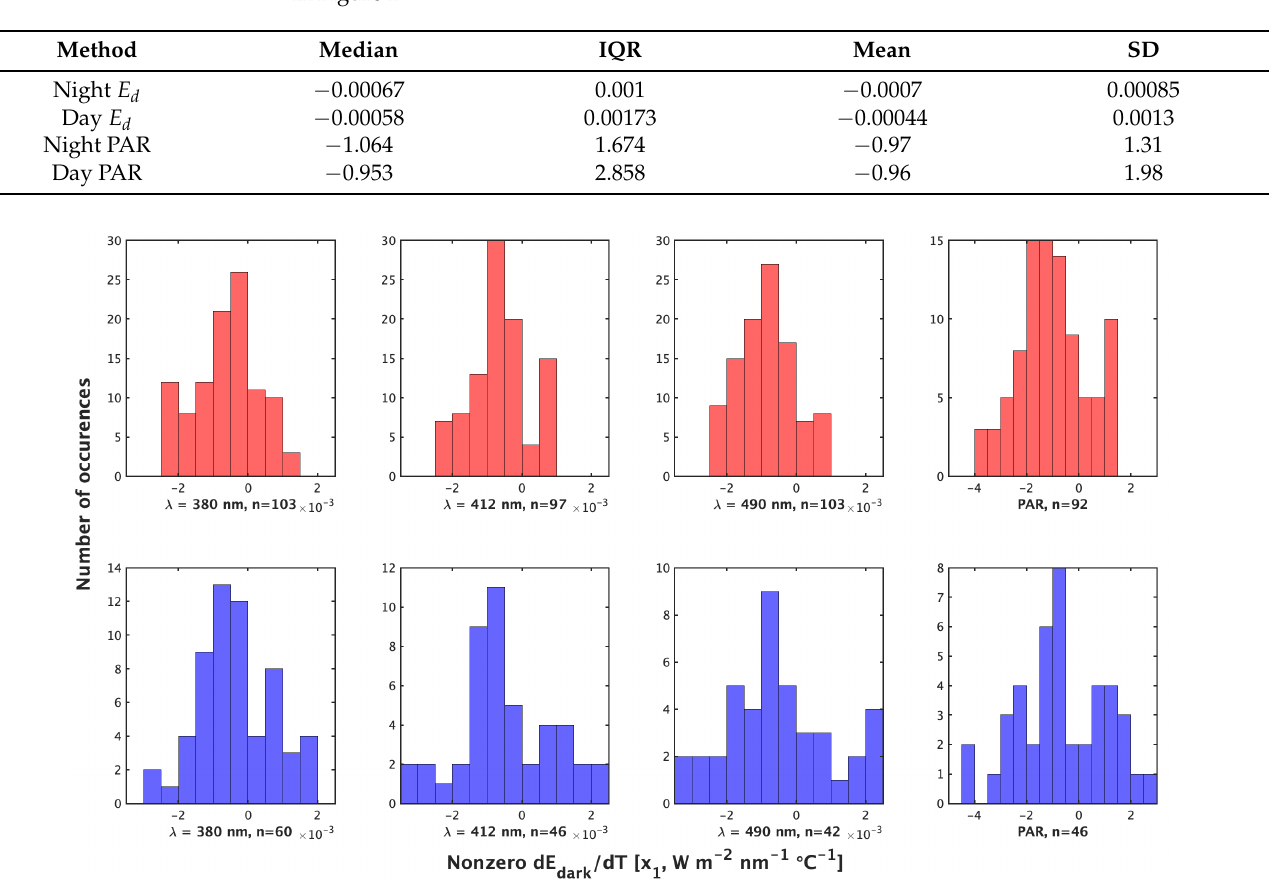
Figure 2. Histograms of the non-zero value of x 1 = dE d / dT s (W m − 2 nm − 1 ◦ C − 1 ) or dPAR / dT s ( µ mol photons m − 2 s − 1 ◦ C − 1 ) by the night method ( top ) and day method ( bottom ) for ( left to right ) λ = 380 nm, 412 nm, 490 nm, and